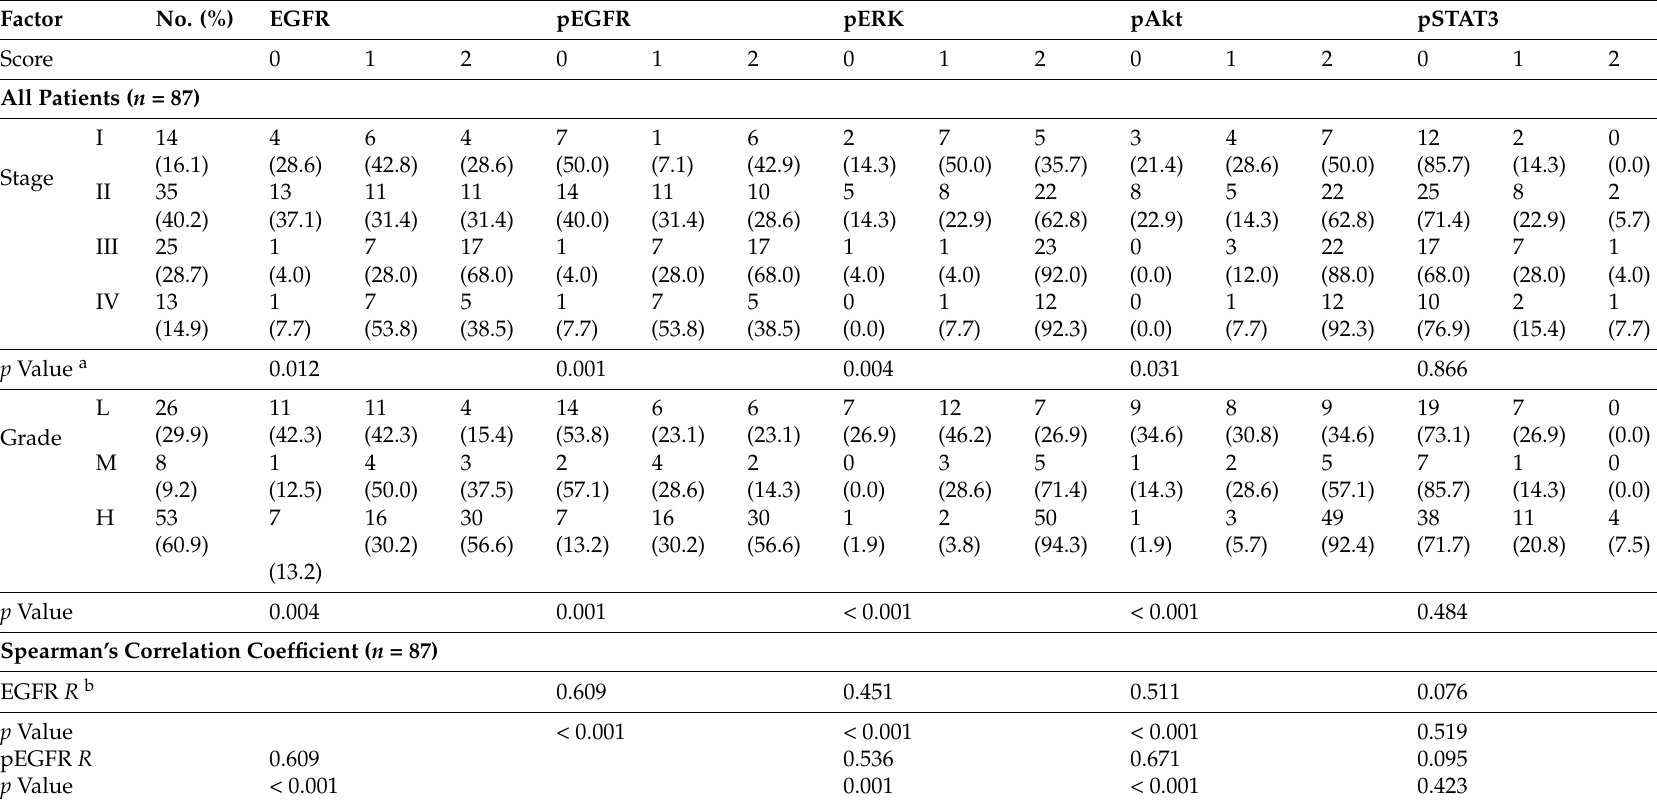
Table 2. EGFR and its activated signal transducers in 87 patients with soft tissue